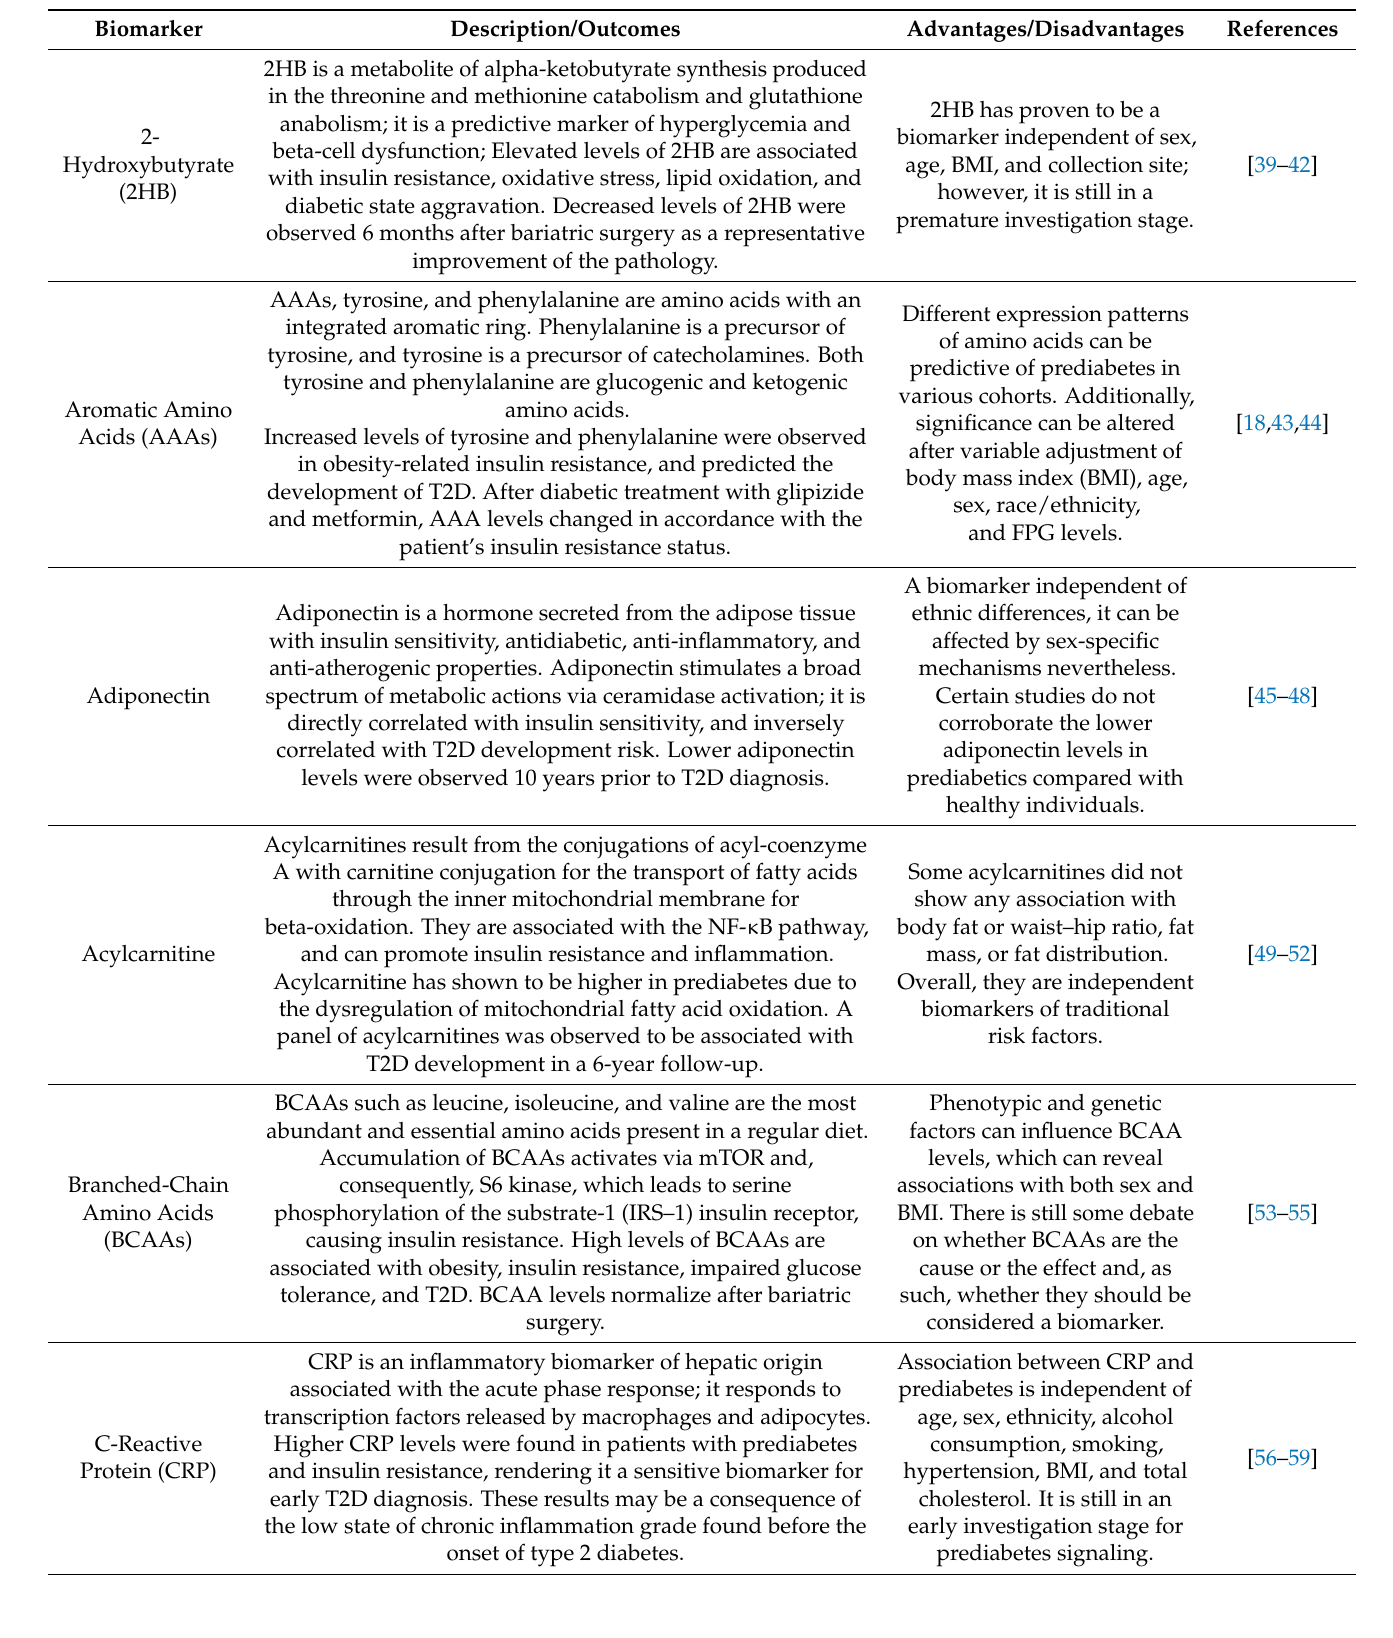
Table 1. Prediabetic biomarkers identified in metabolomics studies: description, outcomes, and identification of their advantages and